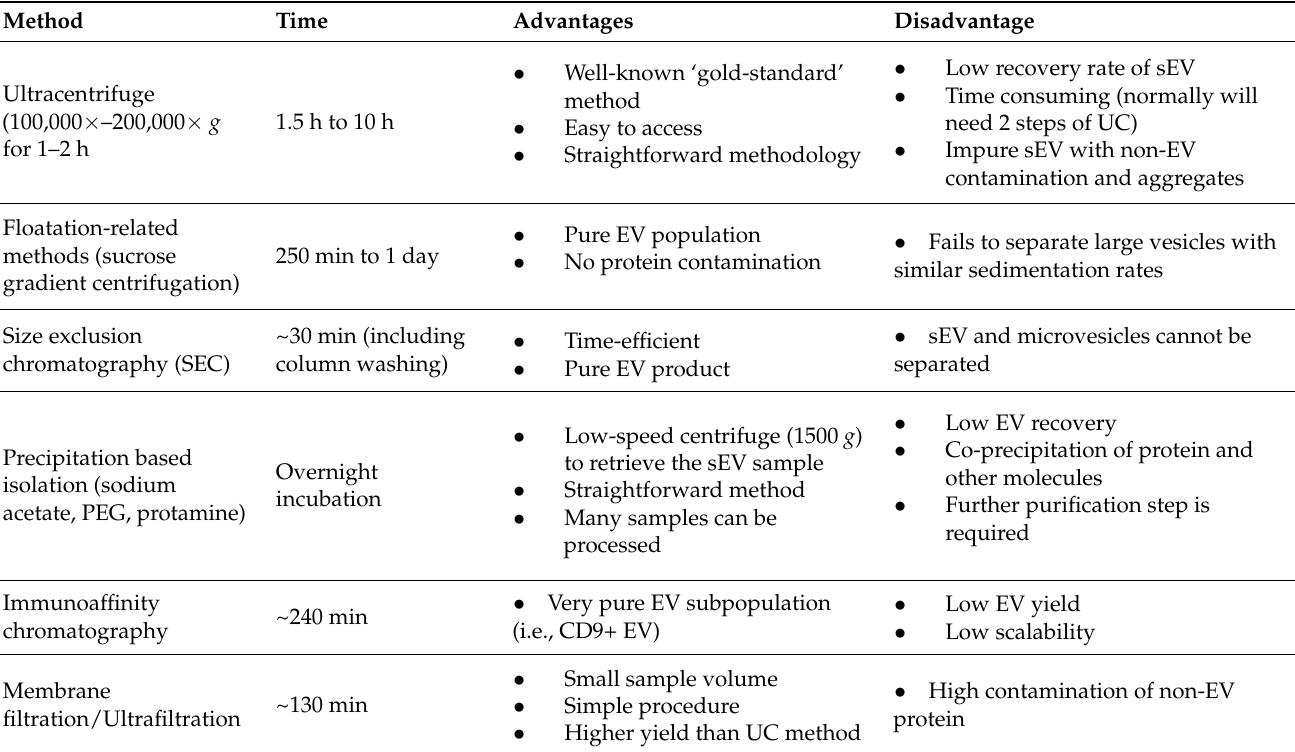
Table 1. Representative advantages and disadvantages of various EV isolation